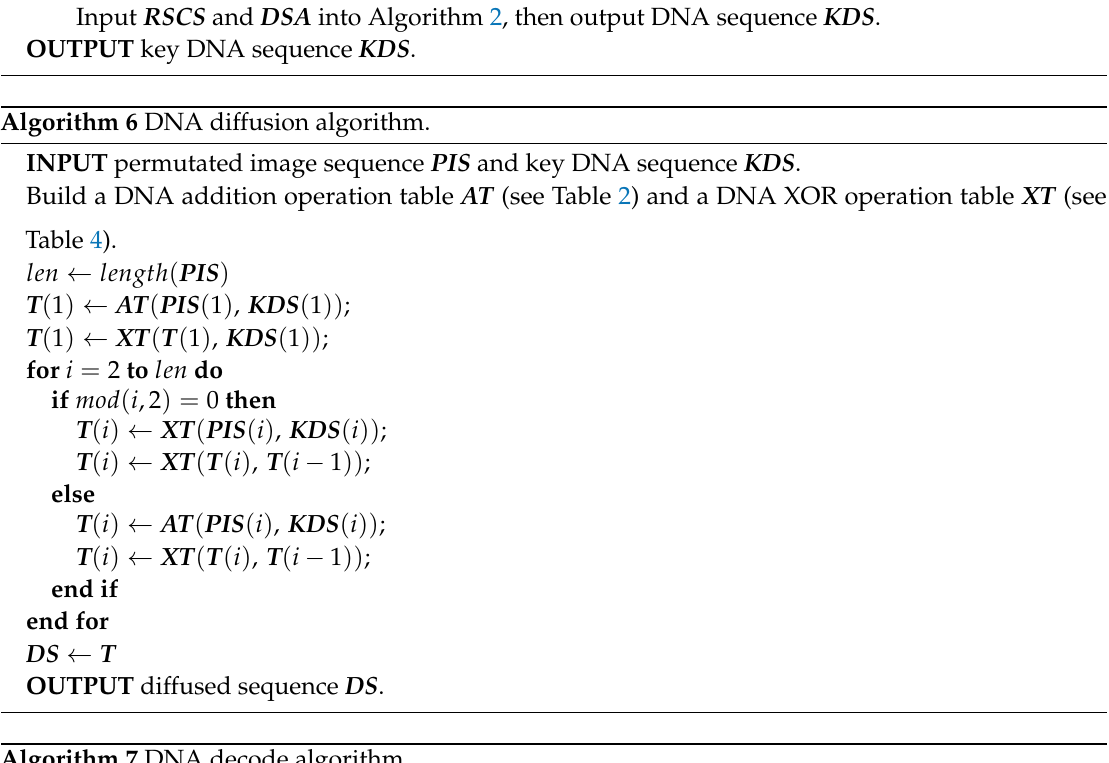
Algorithm 7 DNA decode algorithm. INPUT DNA sequence DS and rules selection control sequence RSCS